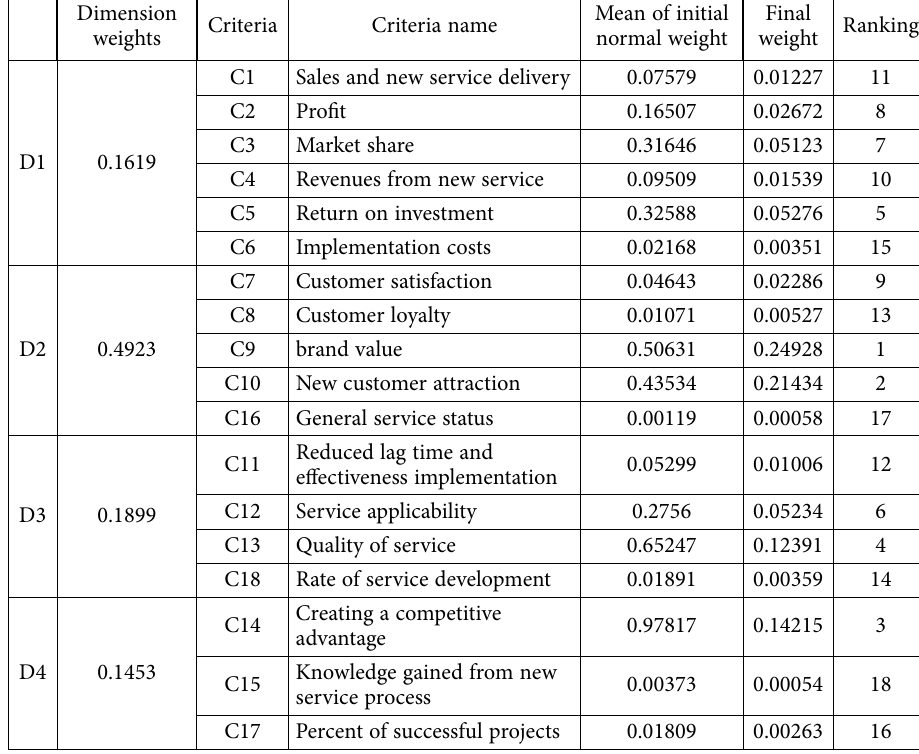
Table 8. Final weights and normalized weights based on expert opinions Dimension